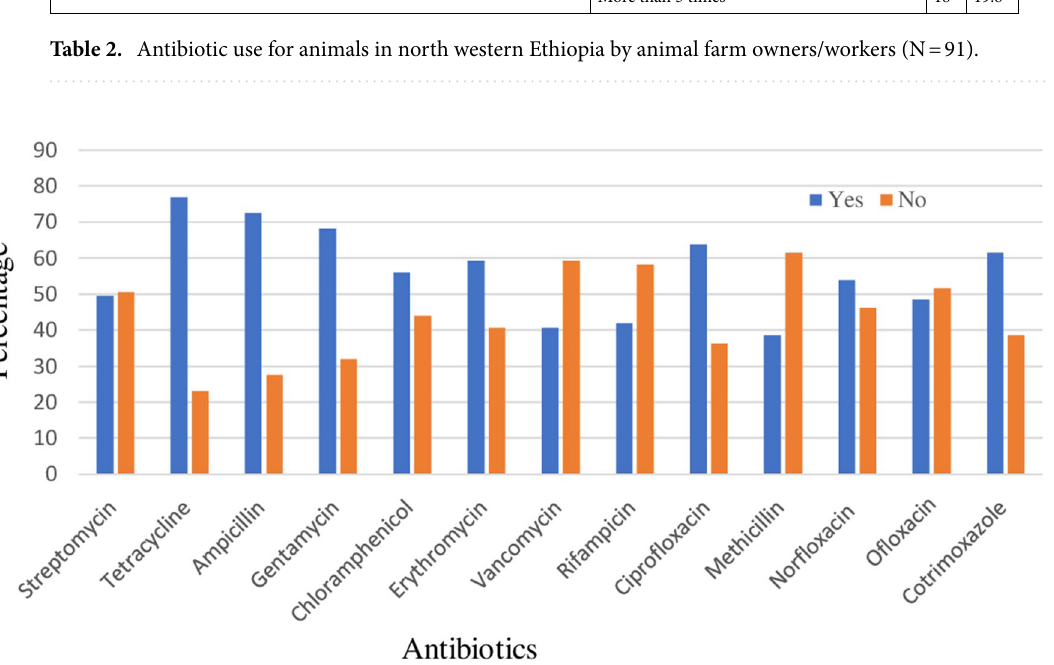
Figure 2. Common antibiotics used by animal farm owners/workers.